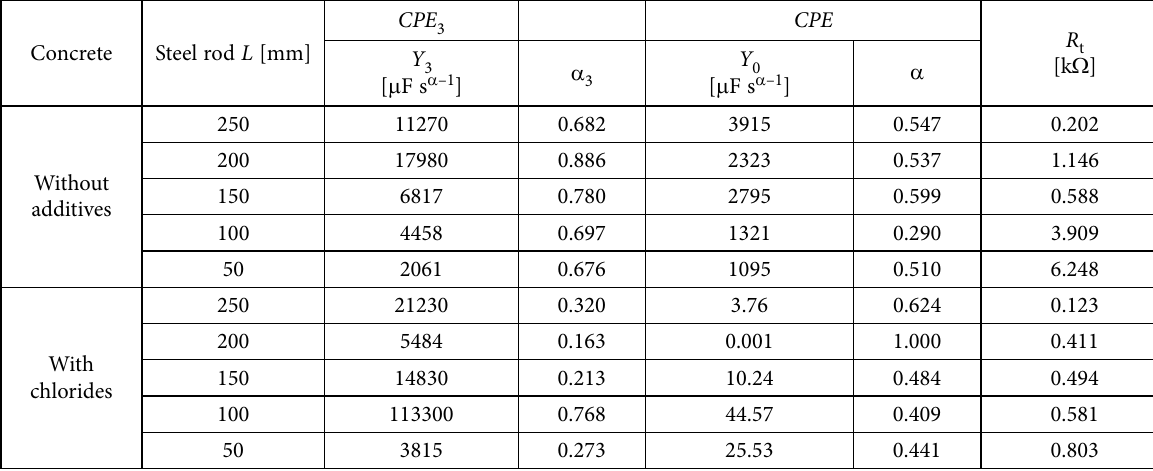
Table 2. The results of impedance spectra analysis – characteristics of